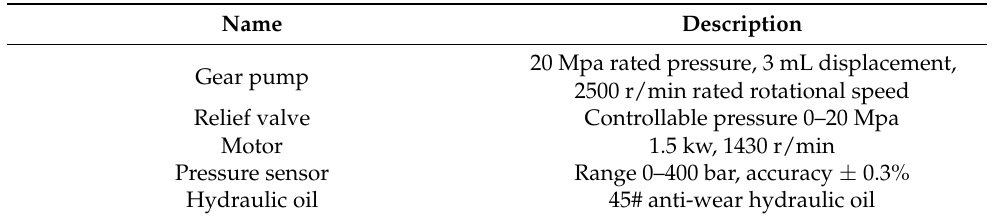
Table 3. Details of the hydraulic components.